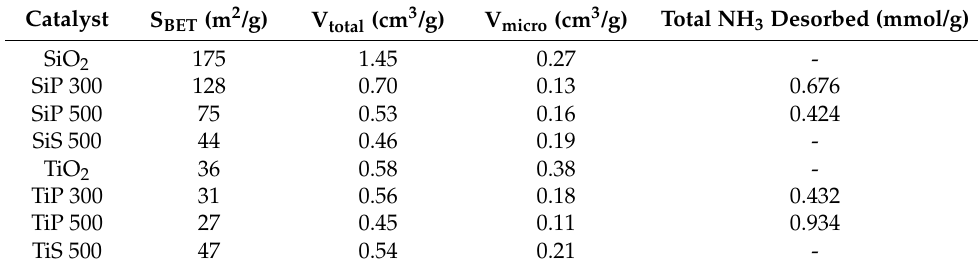
Table 1. Physical properties of sulfated and phosphated catalysts.